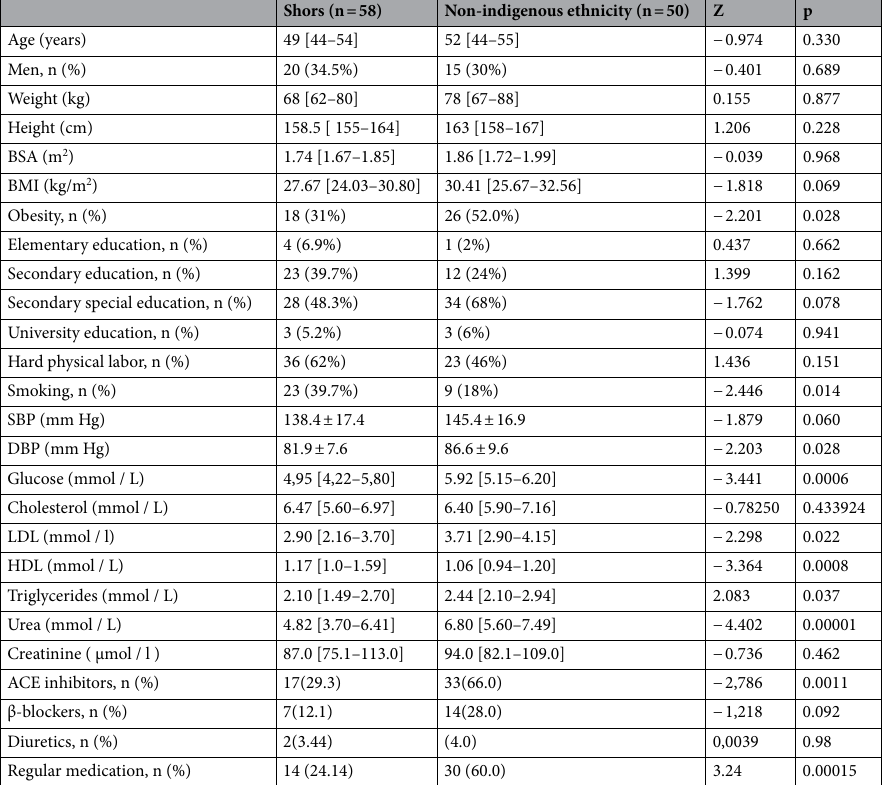
Table 1. General characteristics of hypertensive patients of various ethnic groups. SBP—systolic blood pressure; DBP—diastolic blood pressure, BSA—body surface area, BMI—body mass index; LDL-low-density lipoprotein; HDL—high density lipoprotein; ACE—angiotensin converting enzyme.